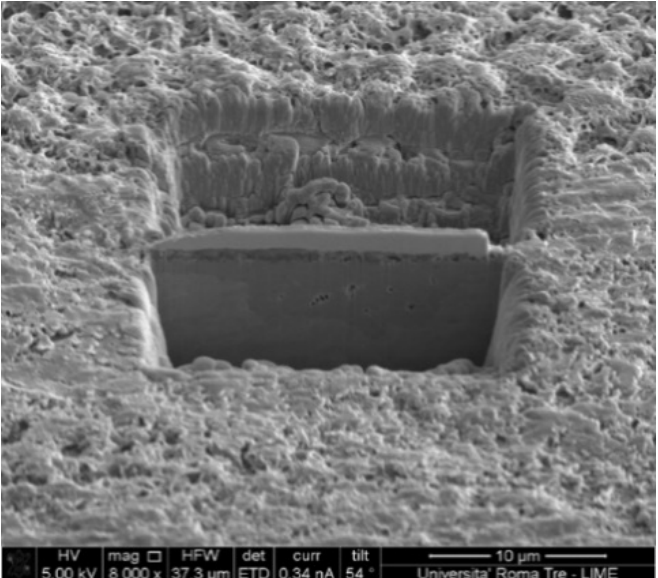
Figure 4. Three-dimensional image of a thin sample during the phase of extraction by FIB-SEM [29]. The image analysis by TEM allowed us to identify the porosity of the oxide scale.